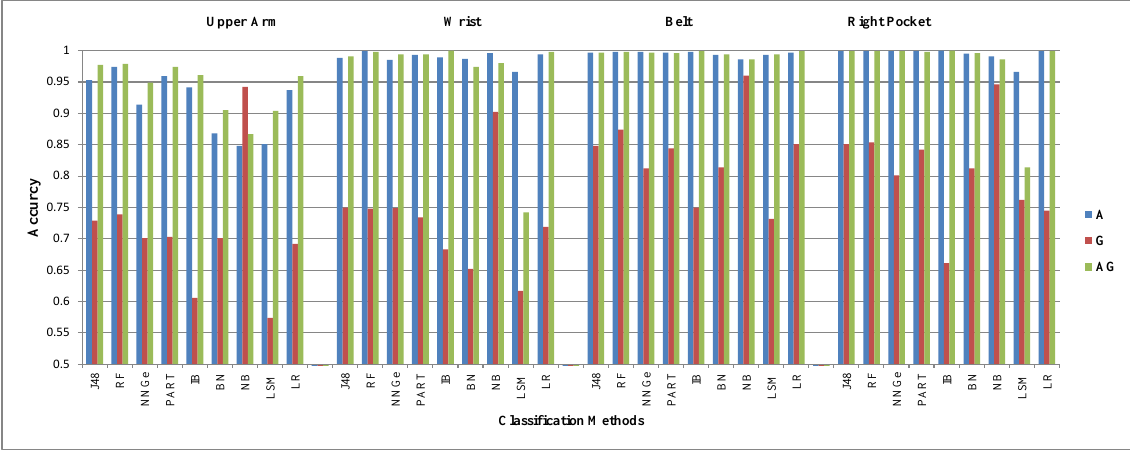
Figure A.5. Recognition performance for the sitting activity at all four positions using FS2.